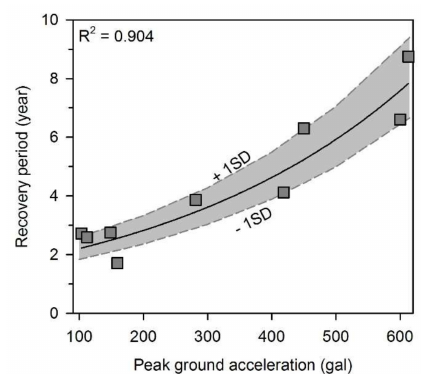
Figure 8. Relationship between peak ground accelerations and recovery periods.